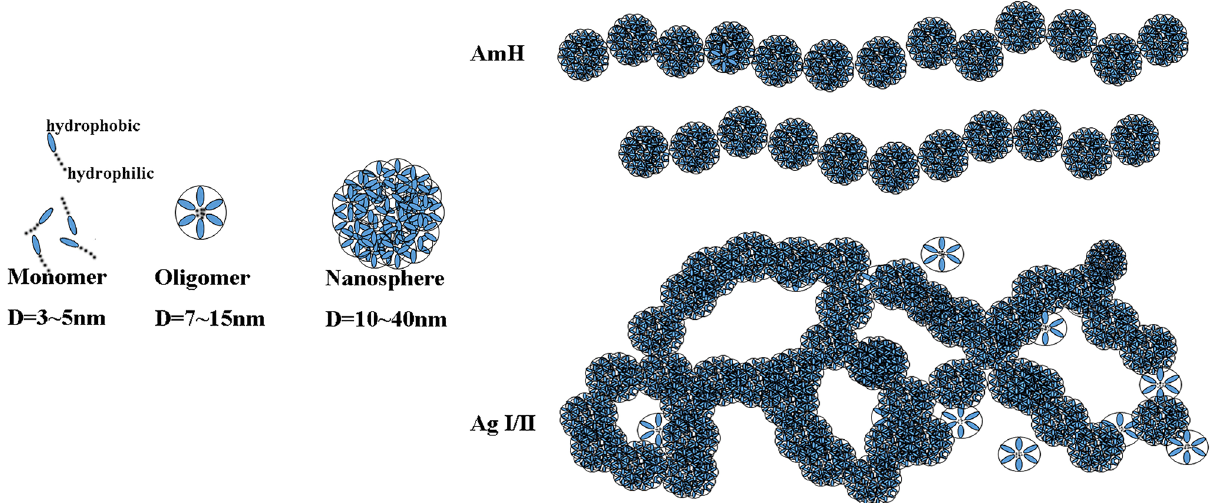
Figure 6. Schematic model of nanochains and nanosphere net. AmH showed end-to-end connection; Ag I/II showed body-to-body connection. The monomers (D = 3 ~ 5 nm), oligomers (D = 7 ~ 15 nm) and nanospheres (D = 10–40 nm) in AmH and Ag I/II were probably comparable in size. However, the long linear structure of Ag I/II offered open-ended connection sites, which induced body-to-body link. As compared to the end-to- end connections seen in AmH, this multipoint joint increased the number of connection sites and promoted multiple types of crystal nucleation and growth. Therefore, the final structures of AmH and Ag I/II would be nanochains and a nanosphere net.